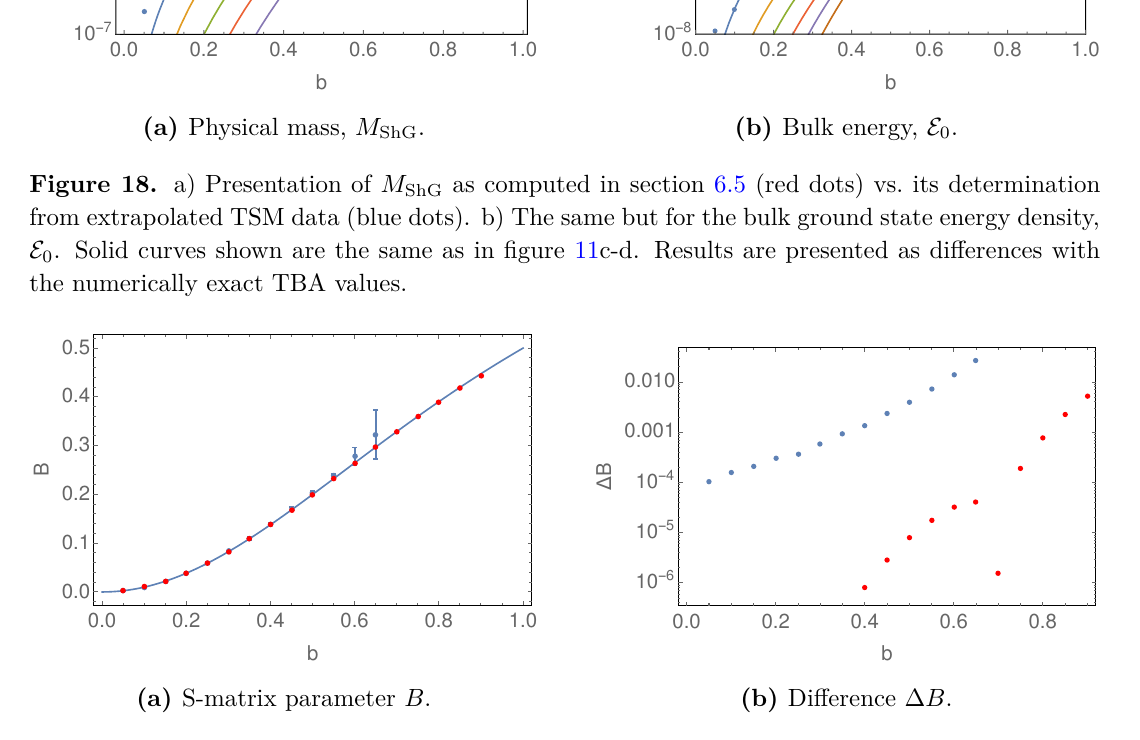
Figure 19. Determination of S-matrix parameter B . a) Absolute values of B. Blue dots (TSM — see figure 12b), red dots (method described in section 6.5), solid curve (exact). b) Differences of determined values of B with exact